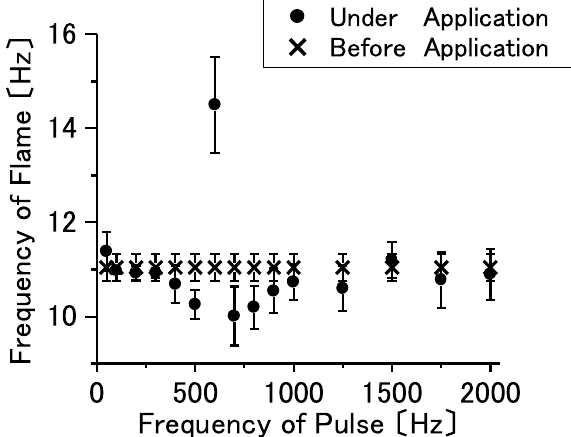
Figure 3. Frequency of the self-excited oscillation of the flame with respect to the frequency of vertically applied electric field are shown. Amplitude of applied electric field is fixed at 5152 V.